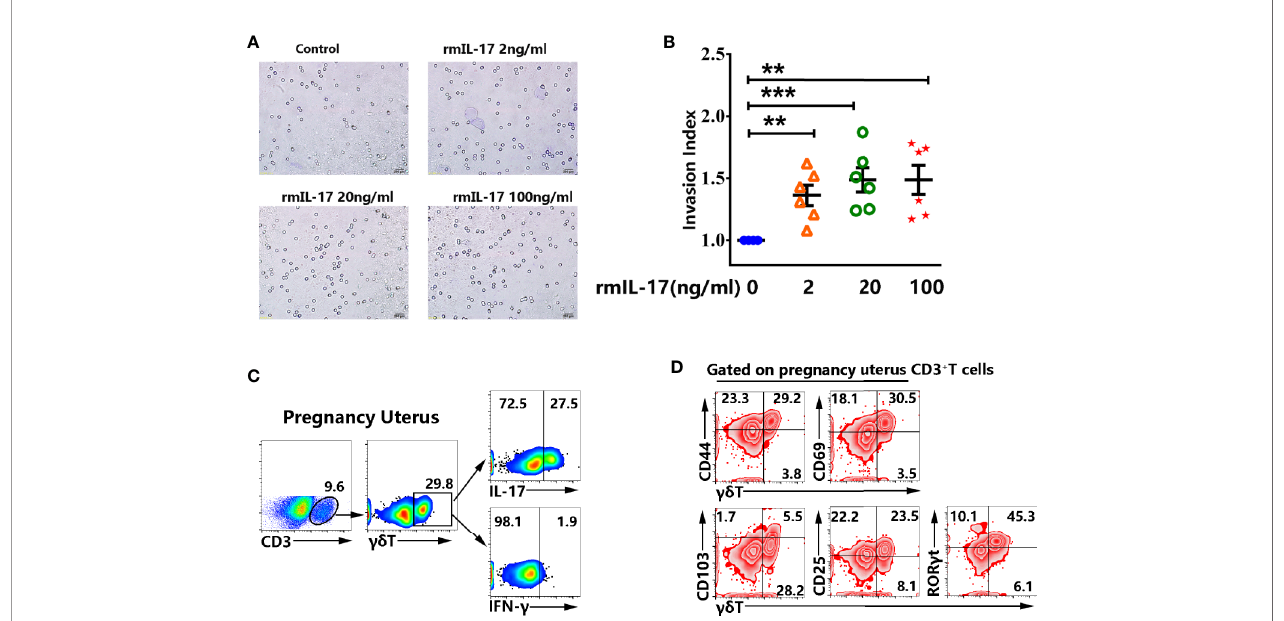
FIGURE 7 | rmIL-17 promoted the invasion of murine trophocytes in vitro . The isolated trophocytes were cultured with different concentration of rmIL-17 (0, 2, 20, 100 ng/ml) at the upper chamber. The trophocytes migrated to the lower surface were photographed and the representative graphs were shown (×200) (A) . The statistical results (B) were expressed the ratio of the mean number of invasive cells with treatment related to the controls. Data were expressed as the mean ± SEM. The mononuclear cells from pregnancy uterus were stimulated with or without PMA plus ionomycin in the presence of BFA for 6 h. The representative graph for the proportion of gd T cells from pregnant uterus and production of IL-17 and IFN- g were shown (C) . Gated on CD3 + T cells in pregnant uterus, the representative graph for the expression of CD44, CD69, CD103, CD25, ROR g t in gd T cells were shown (D) . Data were representative of three independent experiments with 6 mice per group. The statistical signi fi cance was determined with the Mann – Whitney U test. **P < 0.01, ***P <